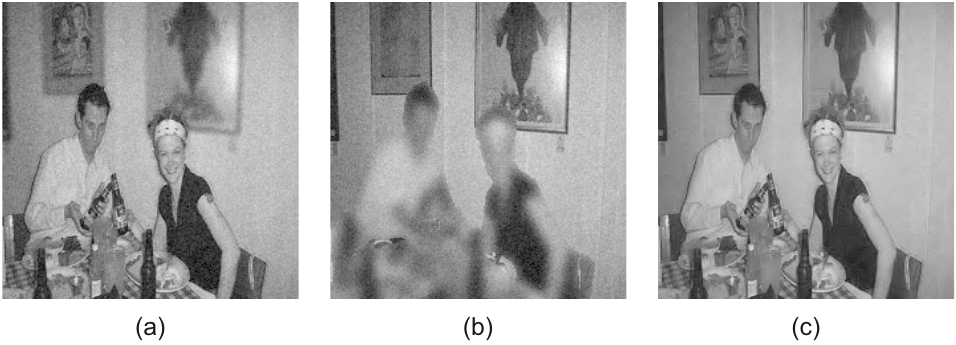
Figure 10. ( a ) Near focused image with Gaussian noise σ = 10, ( b ) Far focused image with Gaussian noise σ = 10, ( c ) Denoised fused